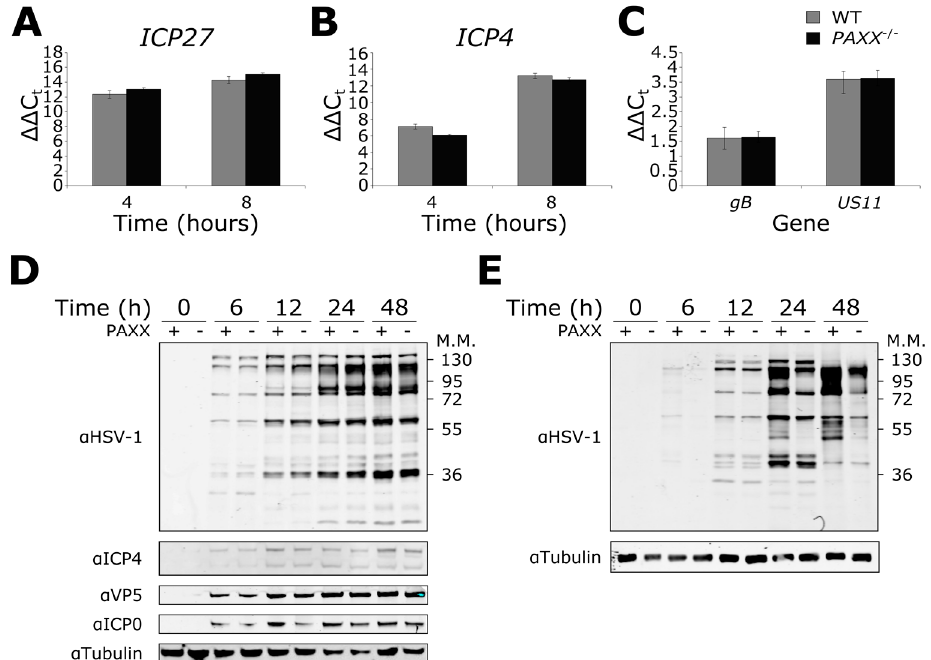
Figure 5. Effects of PAXX on viral gene transcription and protein production. Wild type (WT) or PAXX − / − RPE-1 cells were infected at an MOI of 5, and RNA extracted. qPCR was used to quantify viral transcription of ( A ) ICP27 ; ( B ) ICP4 ; ( C ) gB and US11 ; ( D ) RPE-1 cells were infected at MOI 1 and harvested for protein at various times post infection. An anti-HSV-1 antibody was used, along with specific antibodies. ( E ) As in ( D ), but in MEFs. Error bars denote mean +/ − SEM. n = 3.